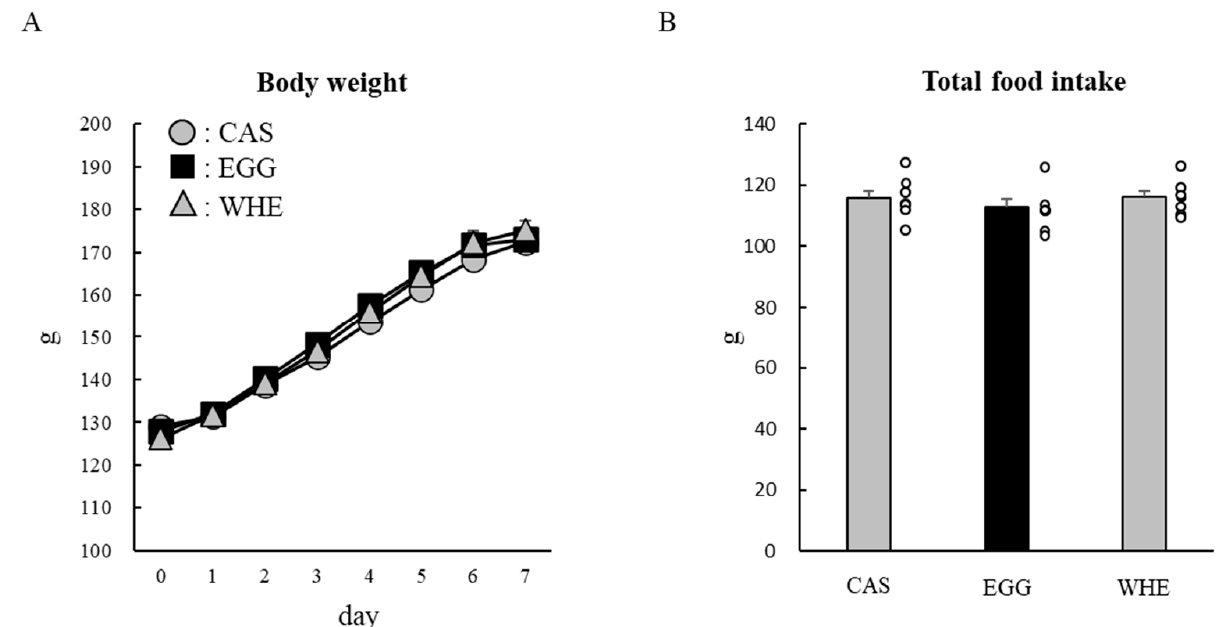
Figure 7. Chronic effect of each protein feeding with arginine-modification on body weight and food intake (during 7 days). Rats were assigned to either a casein, egg white, or whey protein diet group, and were maintained under ad libitum feeding for 7 days without clenbuterol administration. Bodyweight ( A ) and food intake were measured daily. Total food intake ( B ) was the sum of consumed food during 7 days. The dots beside bars indicate individual value. Values are means ± SE ( n = 7). CAS: casein protein, EGG: egg white protein, WHE: whey protein.